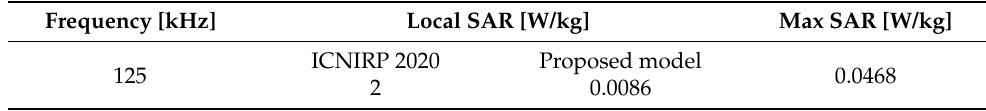
Table 9. Specifics absorption rate (SAR) of proposed